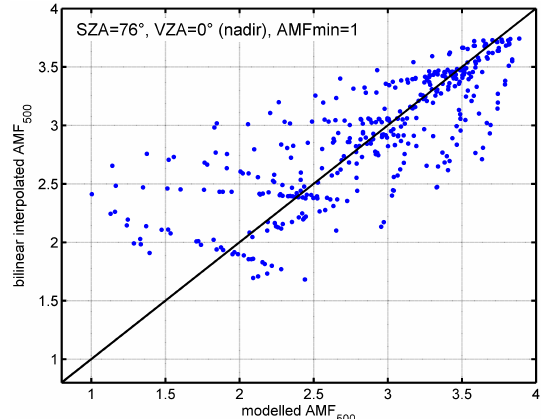
Fig. 8. Comparison between modelled/interpolated values for A 500 and values interpolated from the parametrisation at a fixed nadir geometry of SZA = 76 ◦ and a threshold of AMF min Fig.